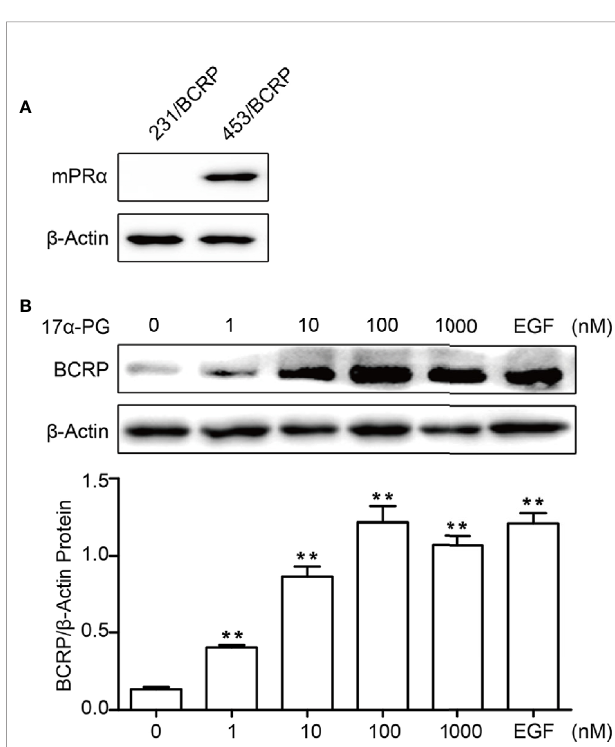
FIGURE 2 | BCRP was regulated by 17 a -PG in mPR a -positive BCa cells. (A) Western blot analysis of mPR a expression in MDA-MB-231/BCRP and MDA-MB-453/BCRP cells. (B) BCRP protein expression in response to treatment with different concentrations of 17 a -PG and EGF for 24 h. The data shown in the histogram are the mean ± SD of three independent experiments. *P < 0.05, **P < 0.01, ***P <